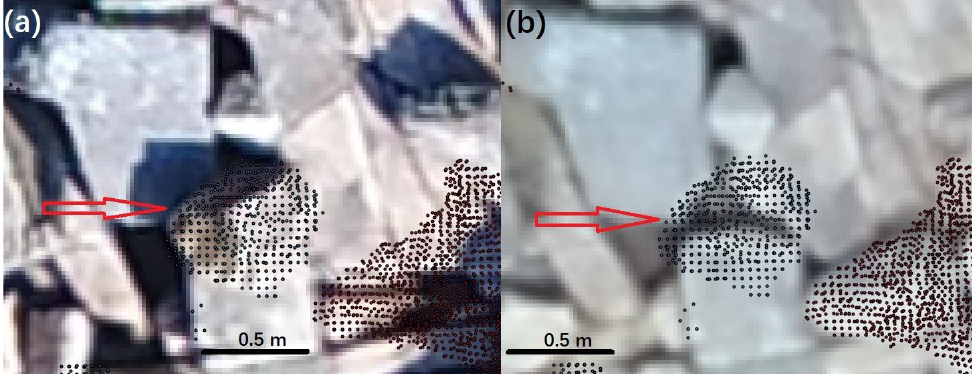
Figure 13. Partially suspended boulder, where ( a ) and ( b ) indicate the location of the boulder in 2017 and 2018 (disappeared), respectively.